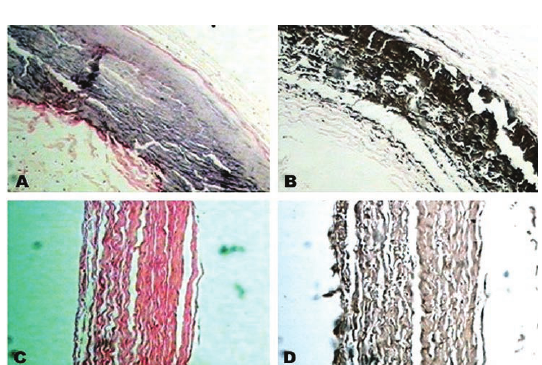
Fig. 2 - Micrografias das amostras de pericárdio bovino explantadas dos grupos controle e tratamento seqüencial. A. Grupo Controle - Hematoxilina-Eosina. B. Grupo Controle - Von Kossa. C. Tratamento Seqüencial - Hematoxilina-Eosina. D. Tratamento Seqüencial - Von Kossa. Aumento